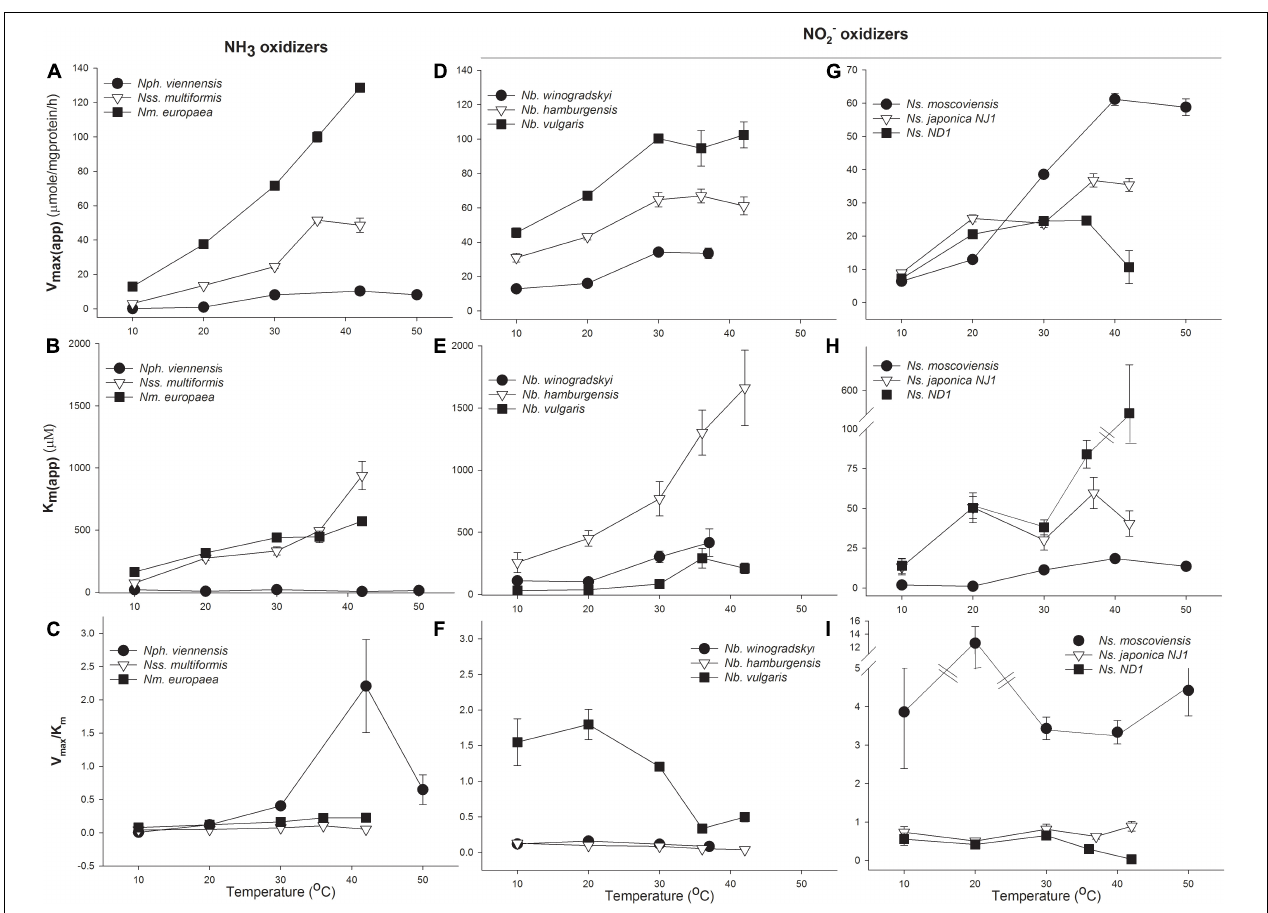
FIGURE 2 | Response of ammonia (NH 3 ) and nitrite (NO 2 − ) oxidizers to temperature. Michaelis–Menten (MM) kinetic parameters for NH 3 -oxidizing bacteria and archaea (AOA, AOB; A–C) , Nitrobacter NO 2 − oxidizing bacteria (NOB; D–F) , and Nitrospira NOB (G–I) . Cultures were grown at their optimal growth temperature, and V max ( app ) and K m ( app ) were determined at the indicated temperatures during short incubations. The response of NH 3 oxidizers is expressed in terms of total NH 3 +NH 4 + ; see Supplementary Table 6 for the response to NH 3 . Catalytic efficiency was calculated as V max /K m . Error bars represent the standard deviation (SD) of the average of three